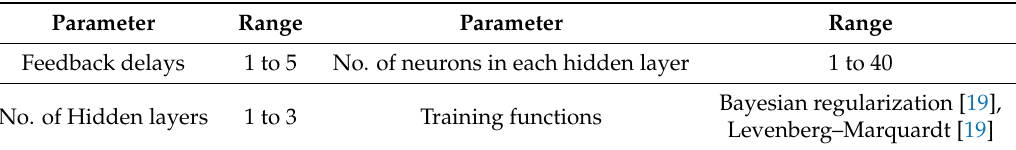
Table 1. Parameters used for developing RNN forecasting model.